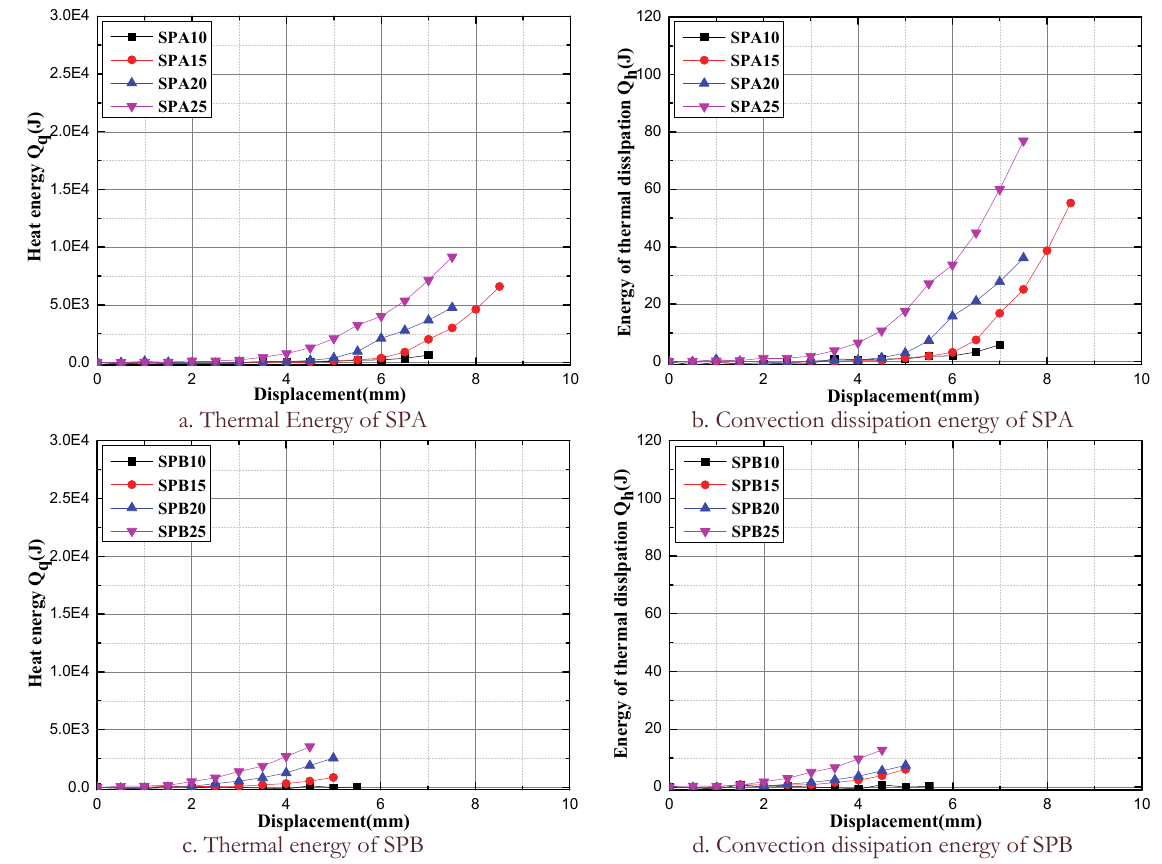
Figure 11: The change of thermal energy during the hysteresis